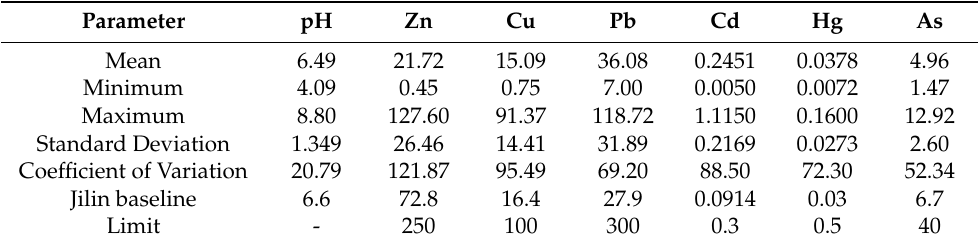
Table 1. Descriptive statistic parameters of toxic elements in